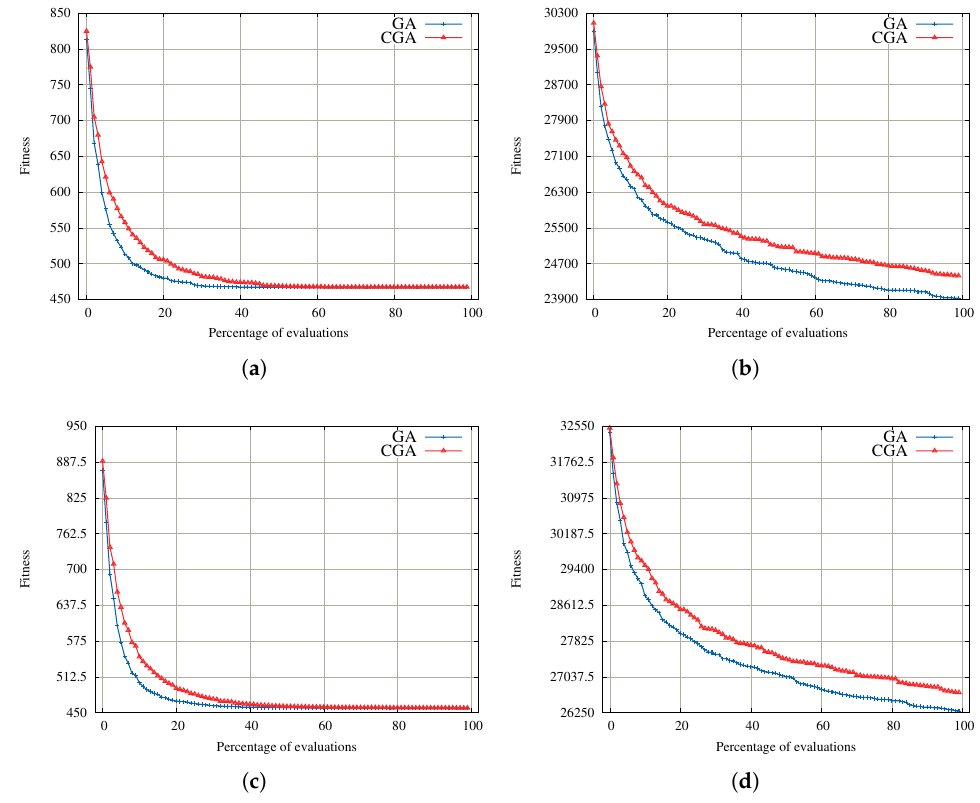
Figure 8. Comparison of the fitness evolution of the GA and CGA for some representative instances. ( a ) Instance 1 from the small set (Small 1 ). ( b ) Instance 5 from the large set (Large 5 ). ( c ) Instance 2 from the small set (Small 2 ). ( d ) Instance 1 from the large set (Large 1